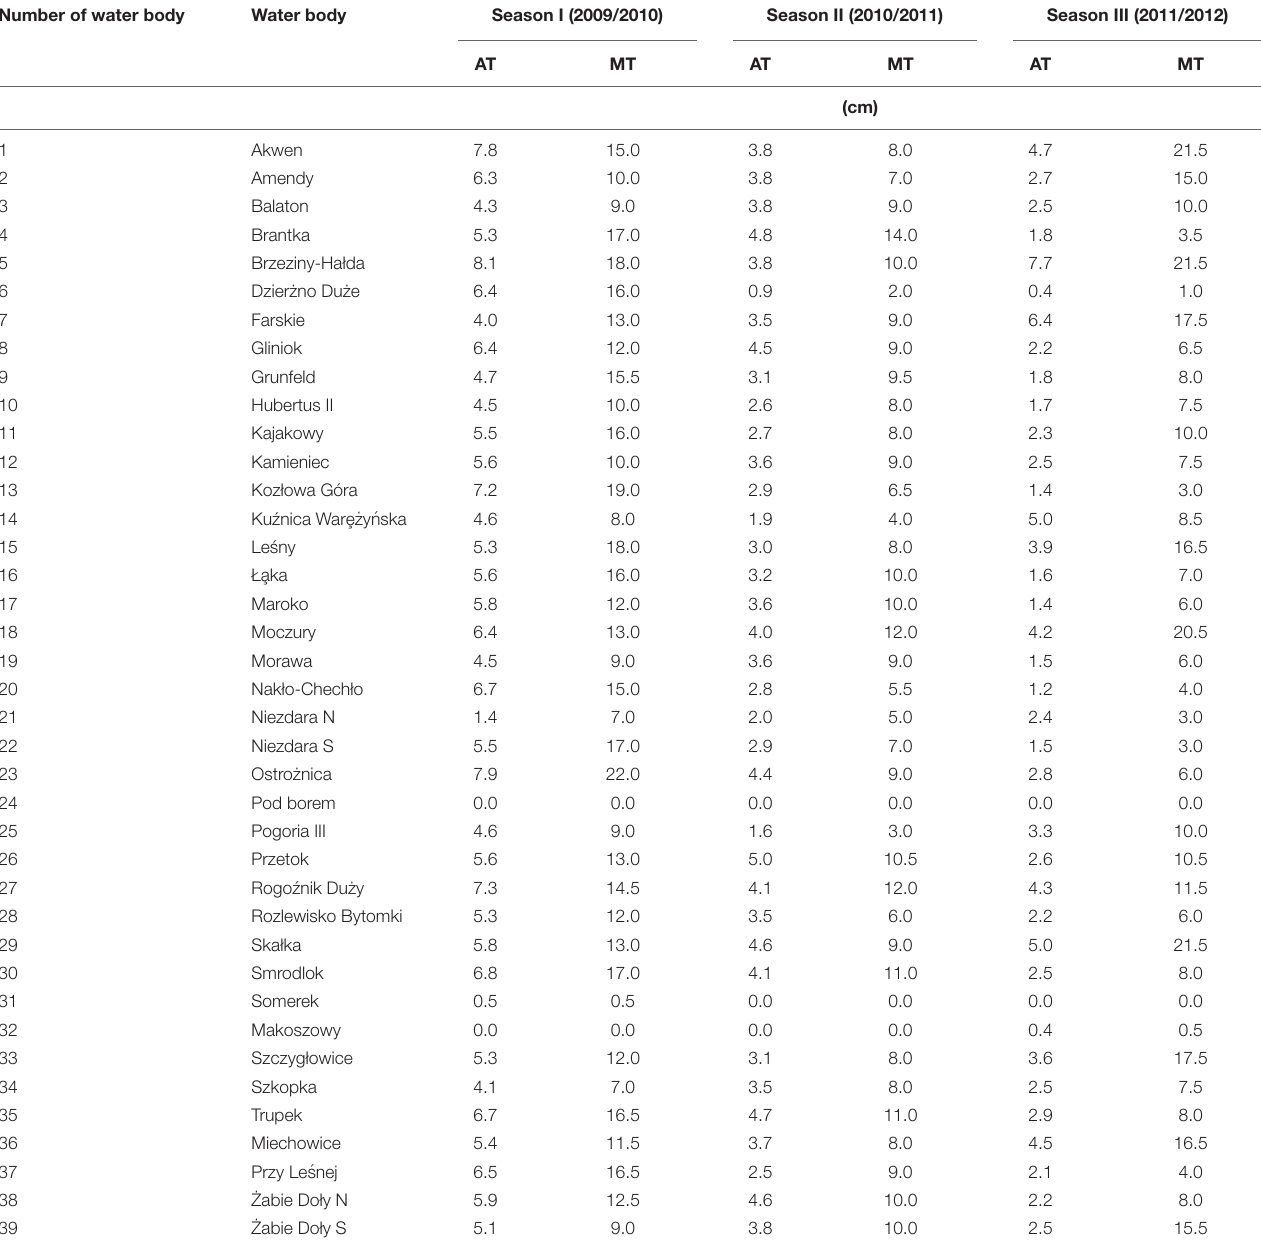
TABLE 2 | Average (AT) and maximum (MT) values of thickness of snow cover on selected water bodies of the Silesian Upland in the winter seasons of 2009/2010–2011/2012. Number of water